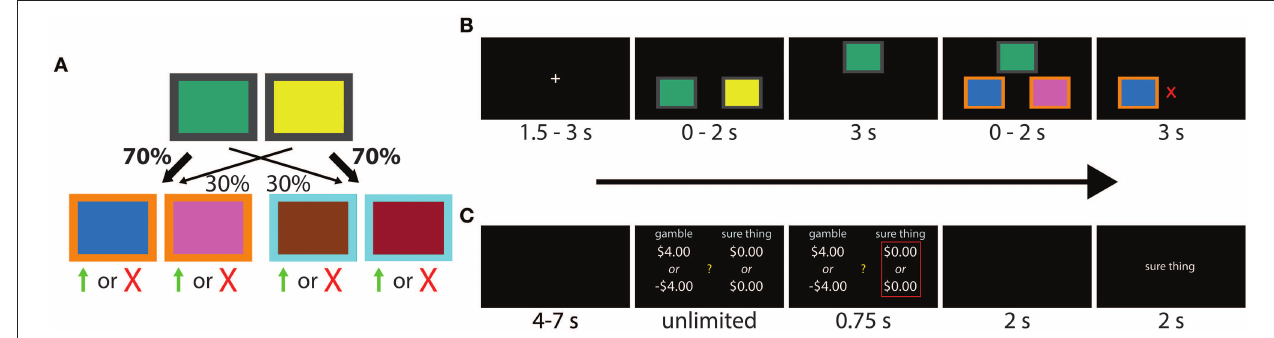
FIGURE 1 | (A,B) Transition structure and sequence of events during each experimental trial of the two-step task. Participants had to make a decision between two fractal images, each leading probabilistically to another pair of images and a second decision. The four second-stage images were associated with independently varying binary payoff probabilities, with reward signaled by a green up arrow (point) or red “X” (no point). The task can be solved using either a model-free (“habitual”) or model-based (“goal-directed”) strategy. Images of fractals were used in the actual experiment, here replaced by colored boxes for publication. Modified from Solway et al. (2017). (C) Sequence of events within each trial of the gambling task. Participants were asked to make a series binary decisions between a 50/50 gamble and a “sure amount” of money.